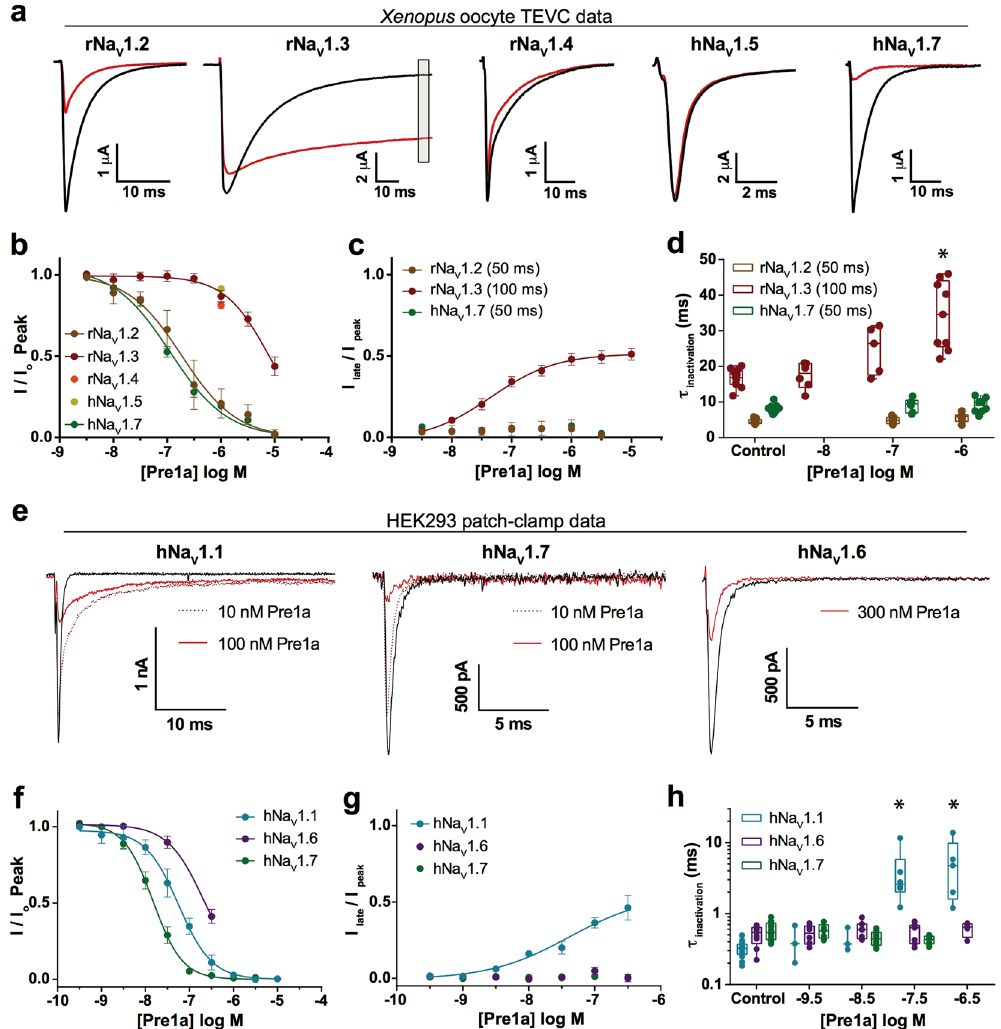
Figure 4. Pre1a preferentially inhibits neuronal Na V channels. ( a) Representative Na V currents recorded from Xenopus oocytes ( α -subunit alone) before addition of 1 µ M Pre1a (black) and after reaching steady state inhibition (red). Late current was assessed at 50 ms (100 ms for Na V 1.3) from the peak current, as highlighted by the grey box on rNa V 1.3. (b) Concentration-effect curves for peak current inhibition by Pre1a for rNa V 1.2 (IC 50 189.6 nM; n ≥ 5), rNa V 1.3 (IC 50 8.0 μ M; n ≥ 8) and hNa V 1.7 (IC 50 114.0 nM; n ≥ 8), with single point 1 µ M concentrations for rNa V 1.4 (n = 6) and hNa V 1.5 (n = 7). (c) Concentration-response curve for late current inhibition of inactivation by Pre1a of rNa V 1.3 (EC 50 45.0 nM). (d) Concentration-dependent effects of Pre1a on the rate of inactivation ( τ ) for rNa V 1.3, with 1 µ M demonstrating a significant slowing of inactivation (p < 0.001; n ≥ 5; ANOVA with Dunnet’s test). (e) Representative current traces of hNa V 1.1, hNa V 1.6, and hNa V 1.7 expressed in HEK cells co-expressed with Na V β 1, in the absence (black) and presence (red) of varying Pre1a concentrations. (f) Concentration-response curves for peak current inhibition by Pre1a for hNa V 1.1 (IC 50 57.1 nM; n ≥ 6), hNa V 1.6 (IC 50 221.6 nM; n ≥ 6), and hNa V 1.7 (IC 50 15.0 nM; n ≥ 9) expressed in HEK cells. (g) Concentration-response curves for Pre1a effects on late current (measured at 10 ms from peak) of hNa V 1.1 (EC 50 41.4 nM), with no measurable effect on hNa V 1.6 or hNa V 1.7. (h) Concentration-dependent effects of Pre1a on the rate of inactivation ( τ ) for hNa V 1.1, with 30 nM and 300 nM demonstrating a significant slowing of inactivation (p < 0.001; n ≥ 5; ANOVA with Dunnet’s